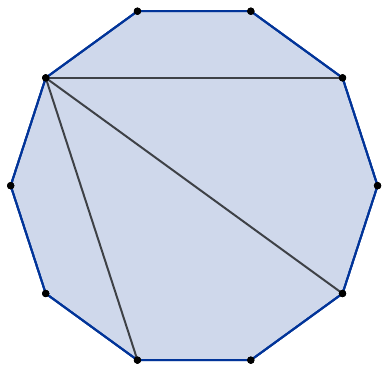
Figure 13 . Dissection (14 , 16 , 18) .